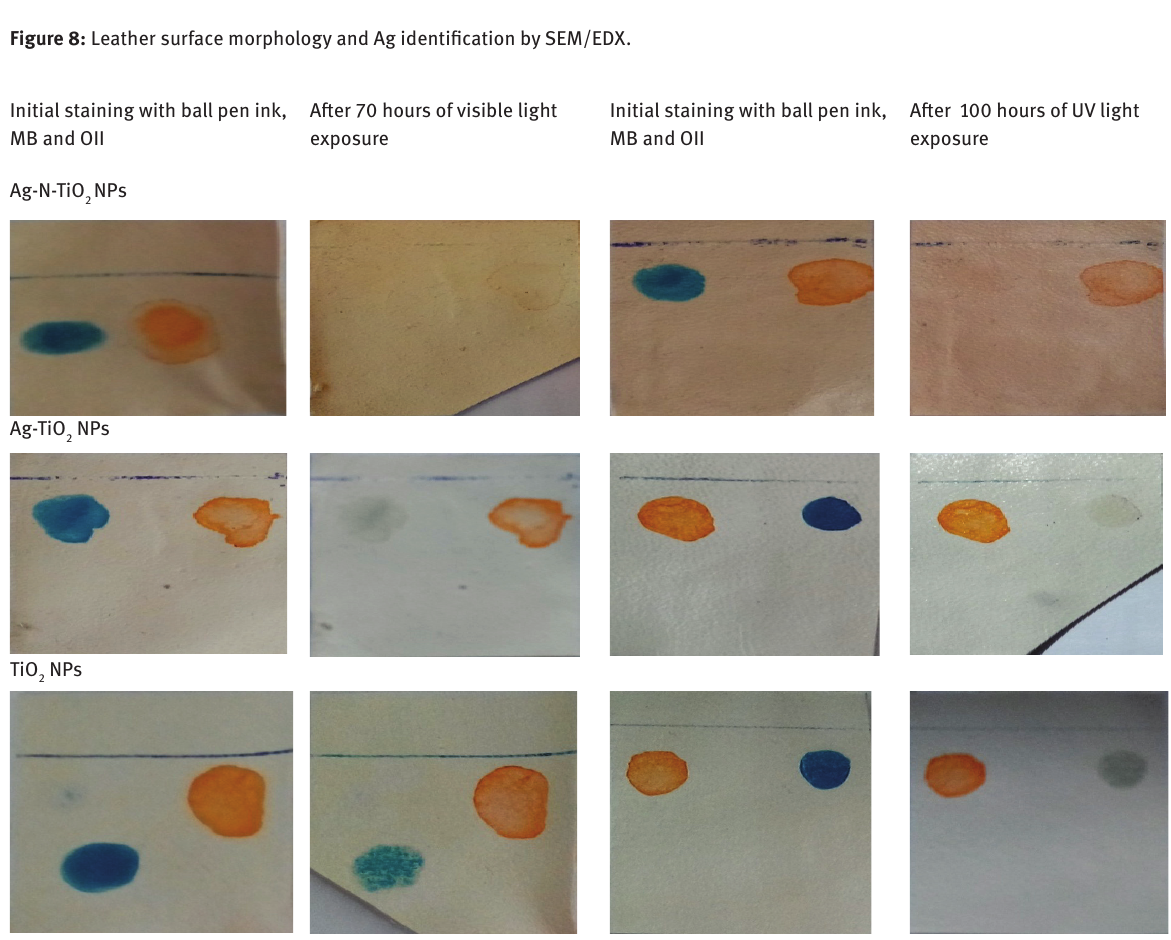
NPs, Ag-TiO NPs and TiO NPs on leather surface exposed to UV and visible 2 2 2